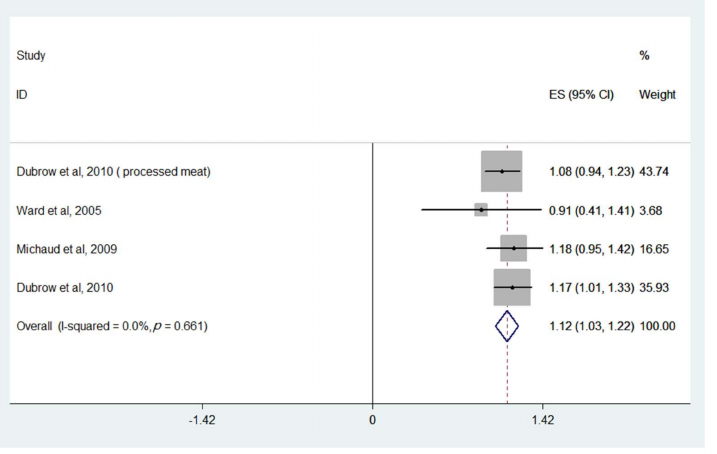
Figure 4. ORs (95% CI) for glioma of all combined higher dosages versus the lowest category of dietary nitrite consumption for the following selected